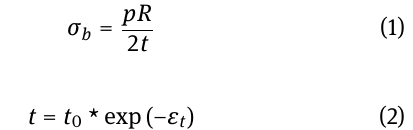
curves too. Scheme of the hydraulic bulge test is shown in Figure 1. Following equations were used to calculate the equivalent stress: